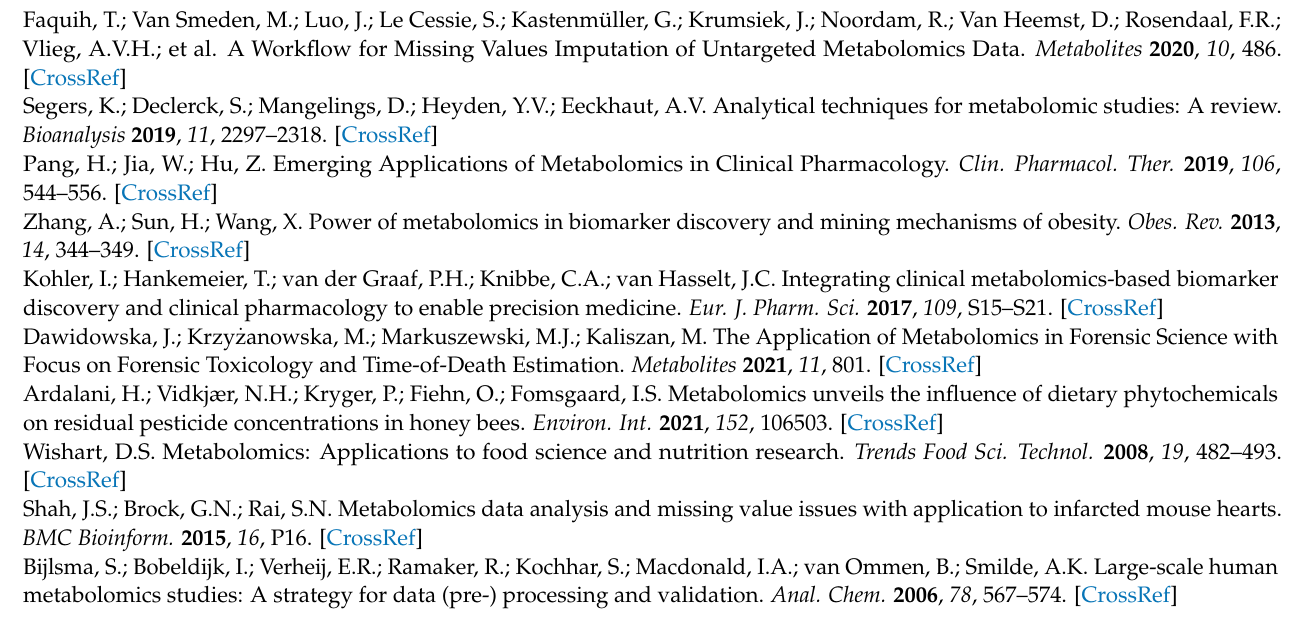
Figure S3: Initial evaluation of MCAR missingness type; Figure S4. Initial evaluation of MNAR missingness type, Table S1: Metabolite statistics across QC pool injections for NIST plasma, baboon plasma, and liver, and data preprocessing parameters; Table S2: Each of the various imputation methods are listed with their respective R package names and